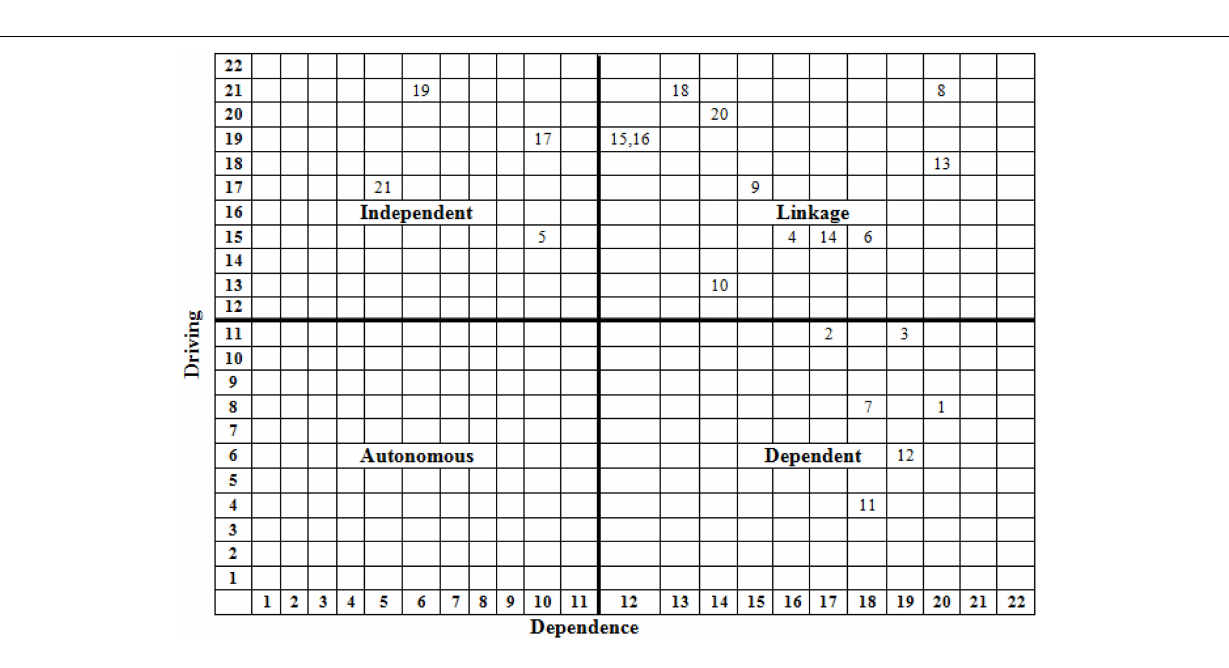
FIGURE 2 | Driving–dependence